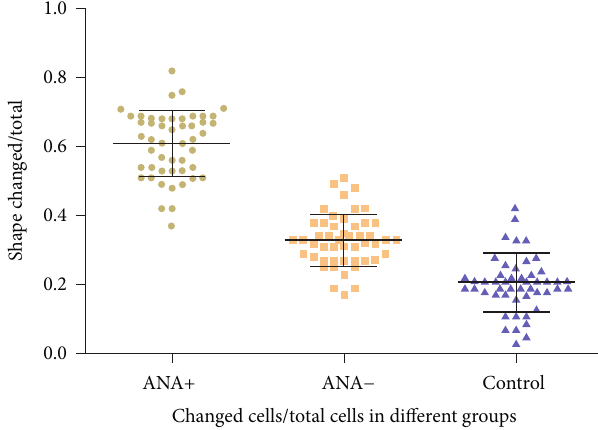
Figure 5: Changed cells/total cells in di ff erent groups. This rate in the ANA+ group was signi fi cantly higher than that in the other two groups ð F = 295 : 812 , P = 2 : 9423 × 10 e − 15 Þ Data was expressed as mean ± SD ( n = 10 for each group, fi ve visual fi elds were selected for each object to get the number of deformed cells, repeated three